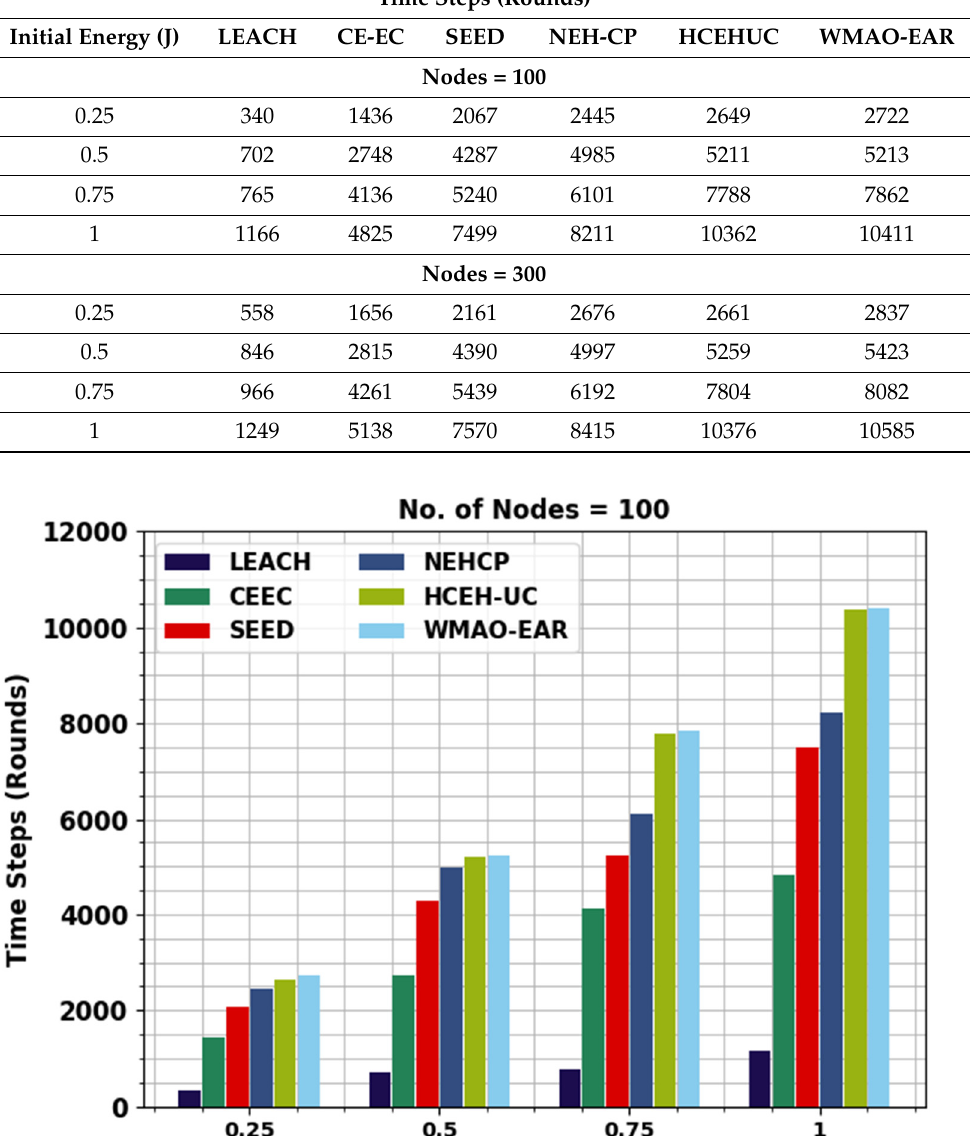
Table 2. EU analysis of WMAO-EAR approach with existing algorithms under NC of 100 and 300.